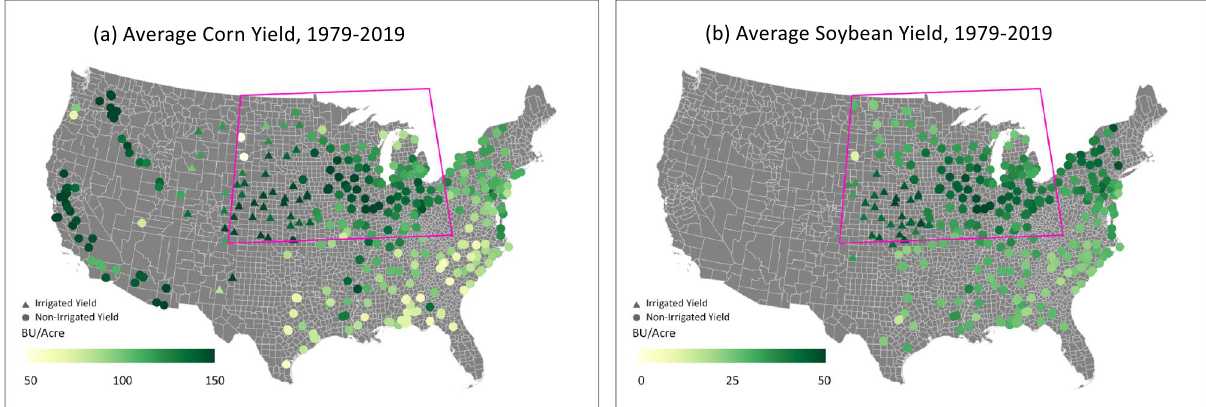
Figure 1. Average corn ( a ) and soybean ( b ) yields in bushels per acre from 1979 to 2019. The magenta outline indicates the commonly-defined U.S. Corn Belt. Circle dots are for non-irrigated yield, and triangles are for irrigated yield. Yield data are taken from the USDA National Agricultural Statistics Service (https:// quick stats. nass. usda. gov) county level data. The maps are made with ArcGIS Pro 2.2.0 with the US base map downloaded from Census Bureau, https:// catal og. data. gov/ datas et/ 2019- carto graph ic- bound ary- shape file- curre nt- census- tract- for- united- states- 1-